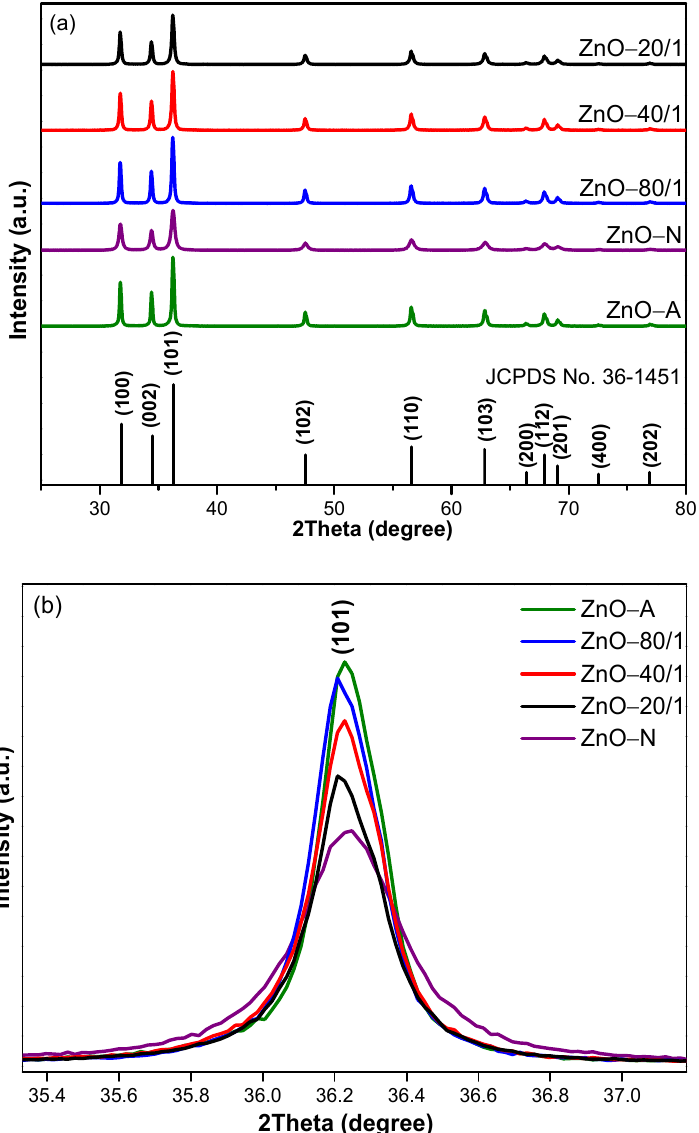
Figure 5. The XRD patterns of ( a ) a wide range of ZnO with different ratios of ZA/ZN and ( b ) the enlarged (101) peak of ZnO ‐ A, ZnO ‐ N, ZnO ‐ 80/1, ZnO ‐ 40/1, and ZnO ‐ 20/1. Table 1. The structure parameter and crystallite size of ZnO powders of (101) plane.